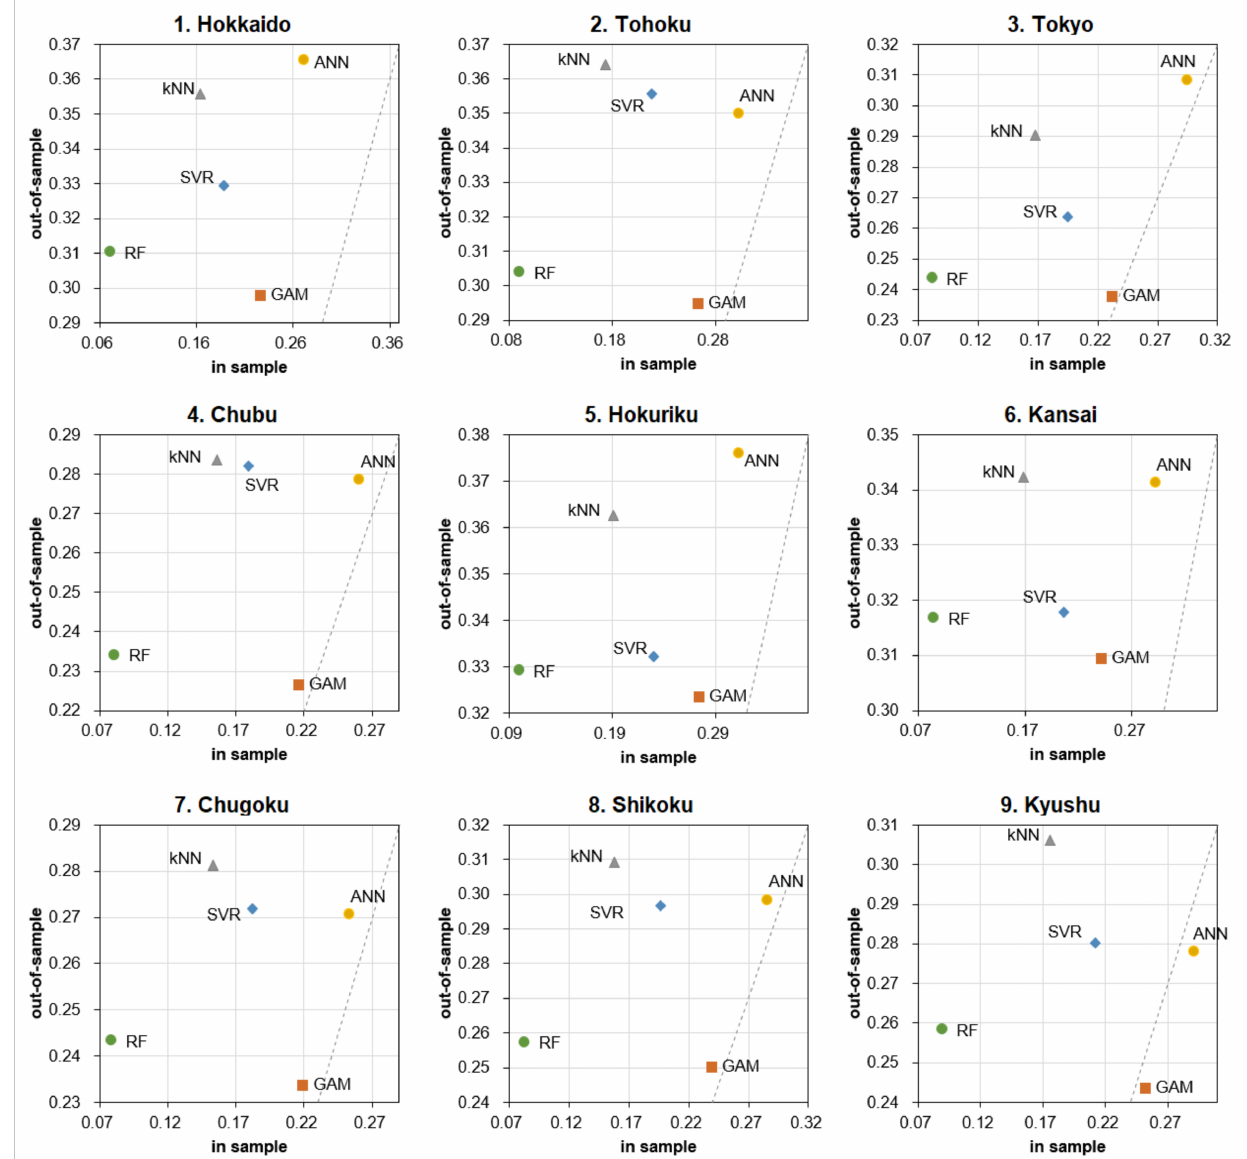
Figure 3. MAE of each method on PV power generation in nine areas. Characteristically, the in-sample forecast errors of RF are minimal in all cases but the out-of-sample errors are larger than GAM. As explained in Section 3, this result reflects the fact that RF regression is prone to overlearning (the fitting image of RF regression is intuitive in the graph in “Section 2” of [44]). However, note that RF is relatively more accurate than the other ML methods even in terms of out-of-sample prediction error; if the sample size in the in-sample period had been sufficiently large, it is possible that the out-of-sample forecast error would have been even smaller. Additionally, although RF showed the longest computation time, it may be possible to reduce the computation time significantly by using a GPU environment instead of a CPU, since parallel computation is possible for the calculation of each decision tree, but such an investigation is left for future work (the same consideration also applies to the empirical results in Section